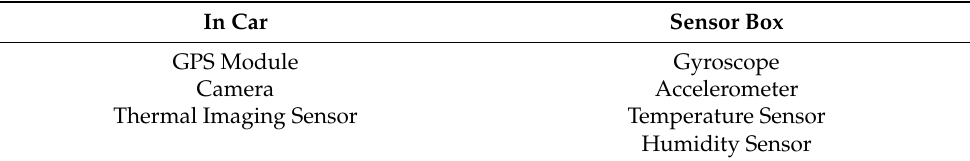
Table 1. Overview of sensors available on test vehicles